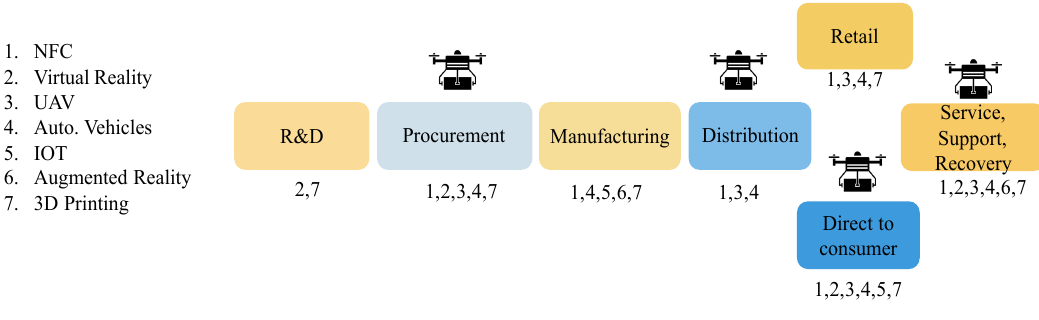
Figure 1. Emerging technologies. throughout the supply chain. Source: based on